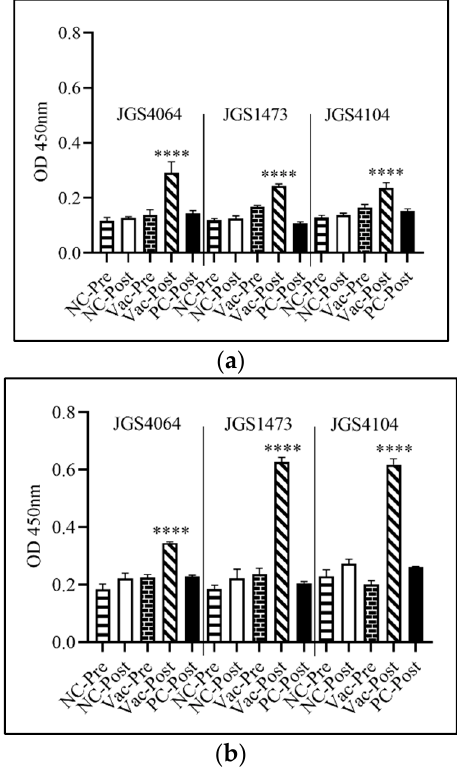
Figure 5. IgY response to CP strains: JSG4064, JSG1473, and JSG4104 using enzyme-linked immunosorbent assay (ELISA). Day 18 chicken embryos were immunized in ovo with either eBeam-killed-JSG4064, eBeam-killed-JSG1473, or eBeam- killed-JSG4104. Pre-challenge sera were collected on day 18 for early-challenge and day 25 for late-challenge. Post-chal- lenge sera were collected on day 22 for early-challenge and day 29 for late-challenge. Each bar represents mean ± SEM. Asterisks indicate a statistically significant difference relative to the post-challenge positive control birds (**** p < 0.0001) determined by one-way ANOVA. OD = optical density ( a ) Early challenge and ( b ) late challenge.